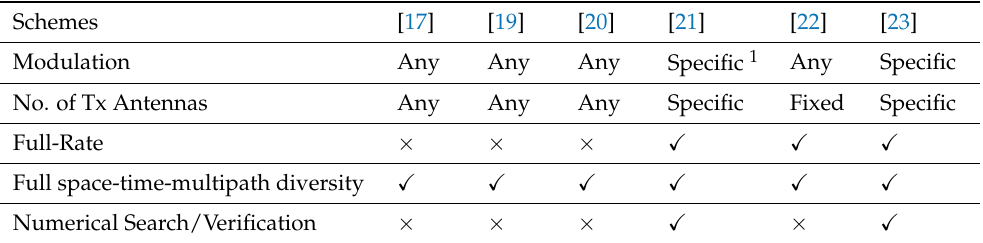
Table 1. Comparison of Single-carrier Space-time Codes for Frequency-Selective Fading Channel ( 1 Specific means that the scheme may require further numerical searches/verification to find the codewords for other types of modulations (or different number of Tx antennas) not shown in their present